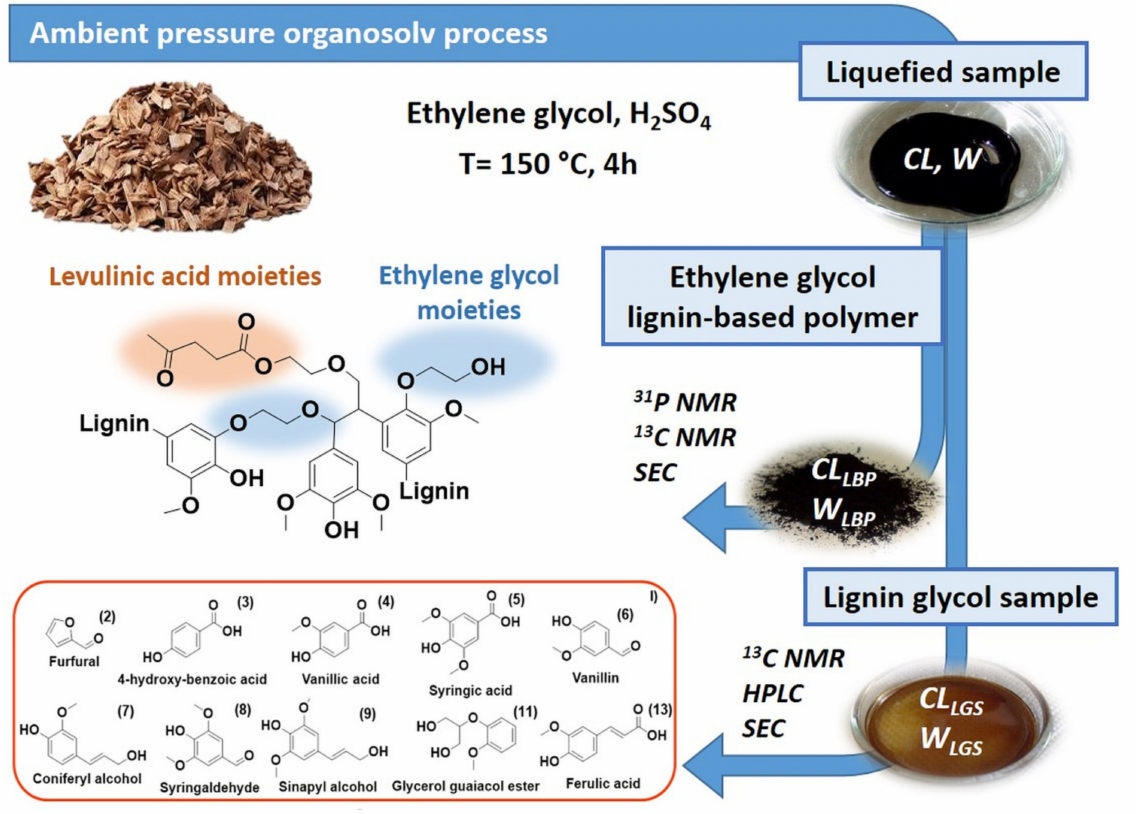
Figure 1. Extended ambient pressure ethylene glycol organosolv treatment (liquefaction) outcome: lignin-based polymer (LBP) and lignin glycol sample